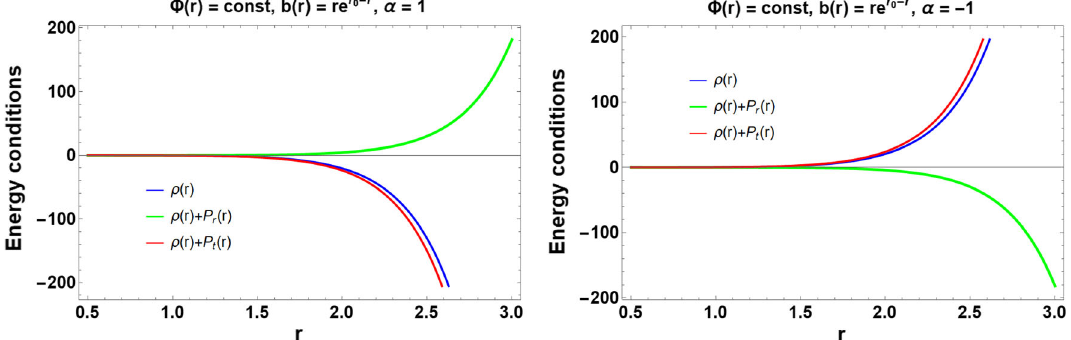
, (cid:10) (cid:5) ( r ) = 0 and b ( r ) = re r 0 − r . The throat Q